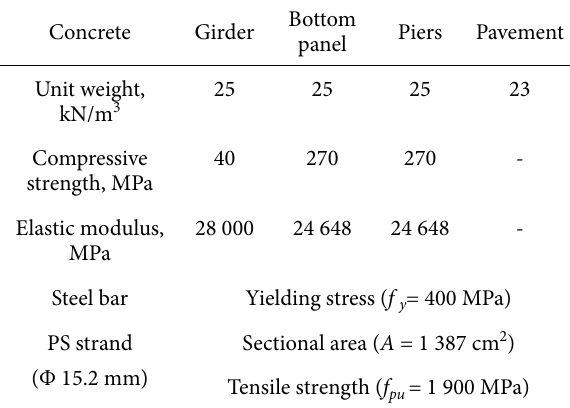
Table 1. Materials used in the selected bridge